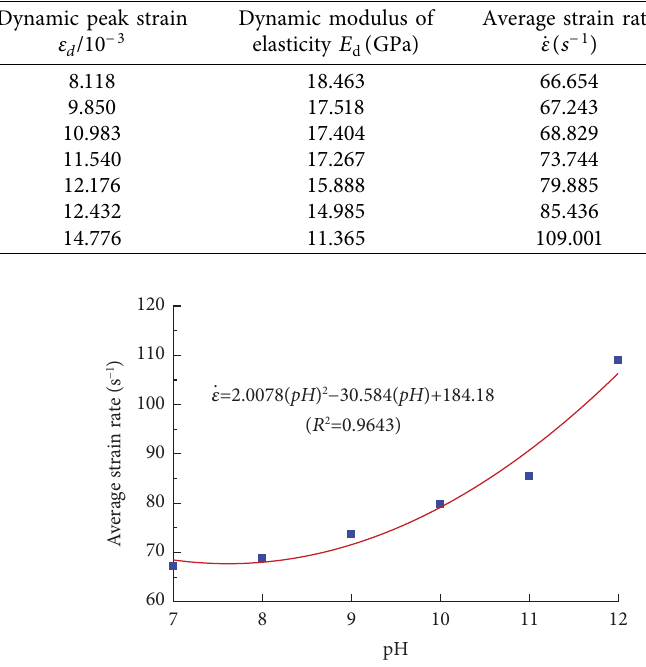
Figure 8: Relationship between dynamic elastic modulus and pH. Figure 9: Relationship between average strain rate and